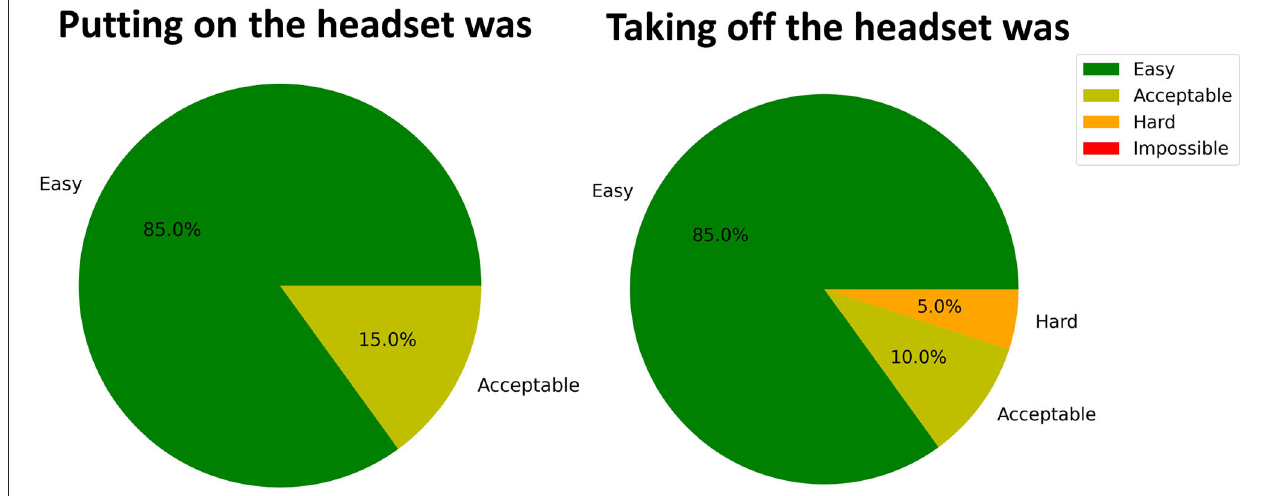
FIGURE 3 | System usability. Easiness perception of headset put-on and take-off. The pie chart shows the percentage distribution of the perceived difficulty rated on the scale Easy, Acceptable, Hard, and Impossible.